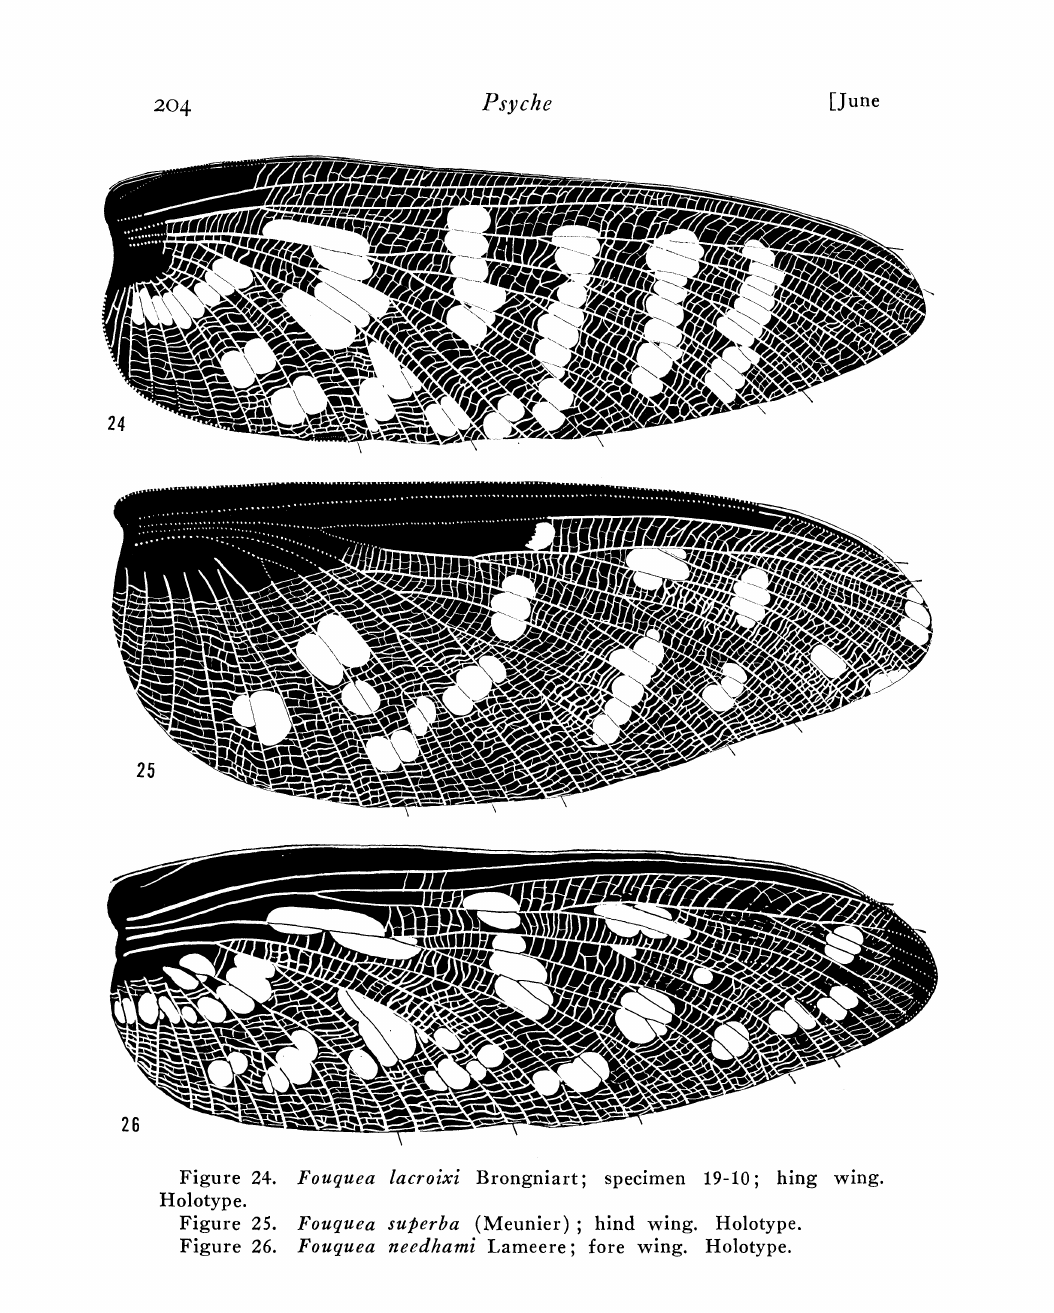
Figure 24. Fouquea lacroixi Brongniart; specimen 19-10; hing wing. Holotype. Figure 25. Fouquea su#erba (Meunier); hind wing. Holotype. Figure 26. Fouquea needhami Lameere; tore wing.